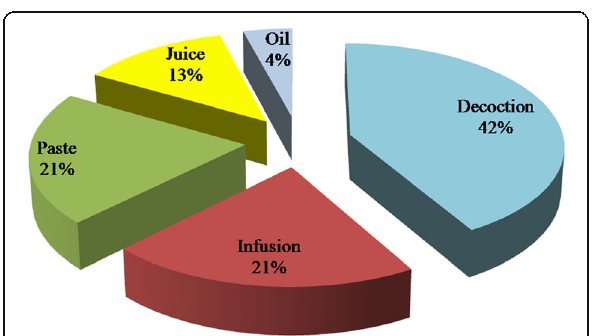
Fig. 2 Frequency of herbal remedies preparation methods which used for the treatment of infertility in females